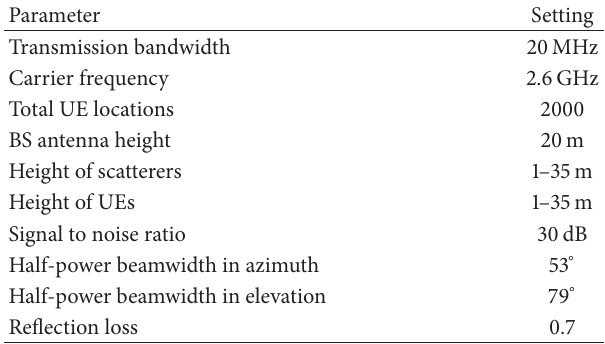
Table 1: Parameter settings for